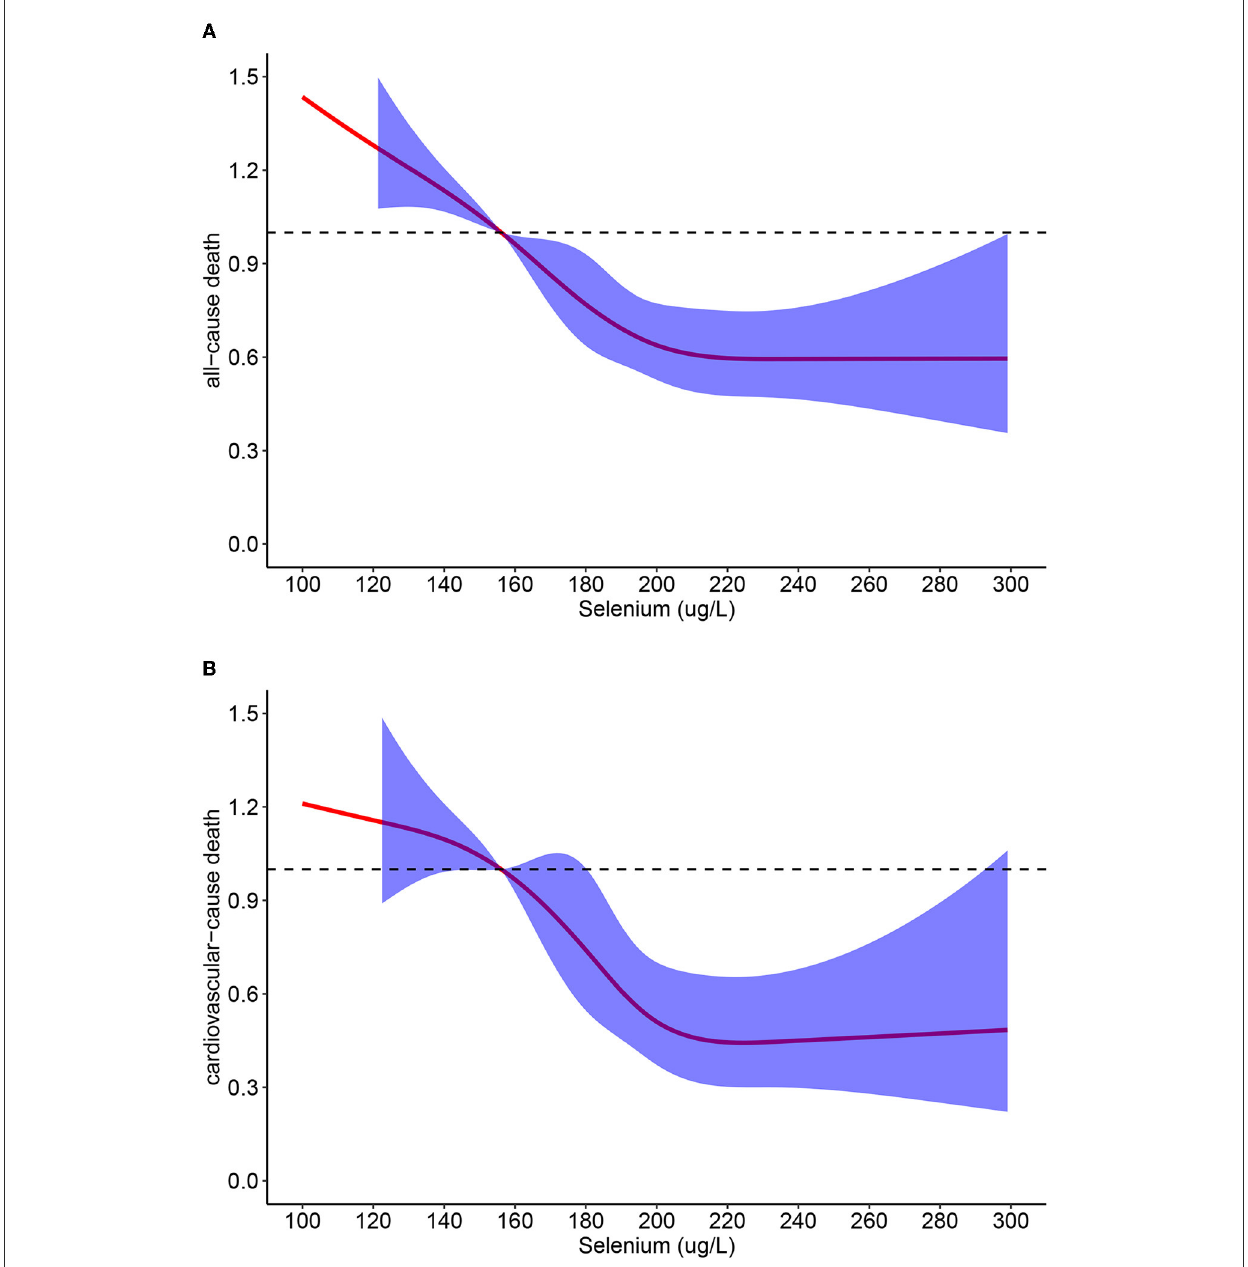
FIGURE4 (A) Restricted cubic spline analyses between serum selenium concentrations and all-cause mortality; (B) Restricted cubic spline analyses between serum selenium concentrations and cardiovascular-cause mortality.